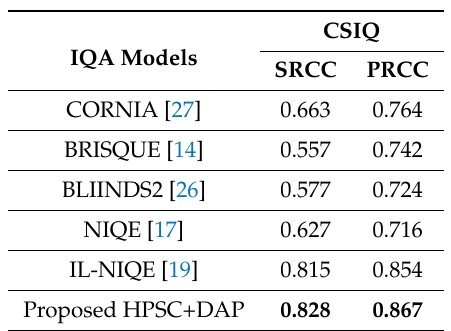
Table 4. Evaluation results of different methods when trained on the LIVE databases and tested on the CSIQ database. The best results are highlighted in bold.